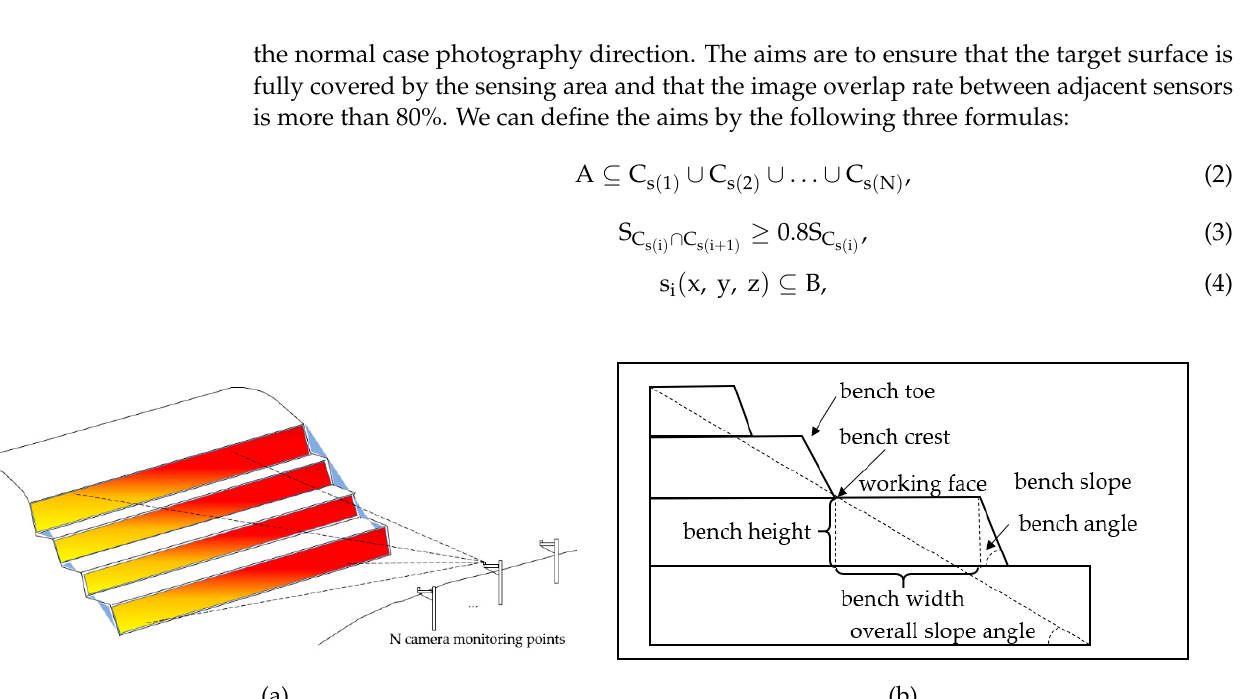
Figure 2. Schematic diagram of the monitoring object. ( a ) Schematic diagram of the monitoring of the open pit slope by cameras. ( b ) Section of the mine slope with the various parts of the open-pit mining.